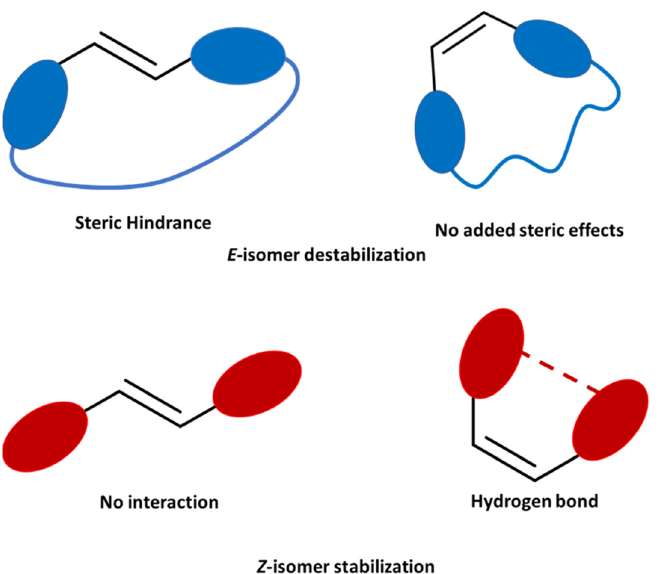
Figure 1. Schematic representation of the proposed strategies to increase the energy storage. ( Top ) In blue the use of a mechanical lock for the increase of the steric hindrance. ( Bottom ) In red, the use of a hydrogen bond to stabilize the Z -isomer.